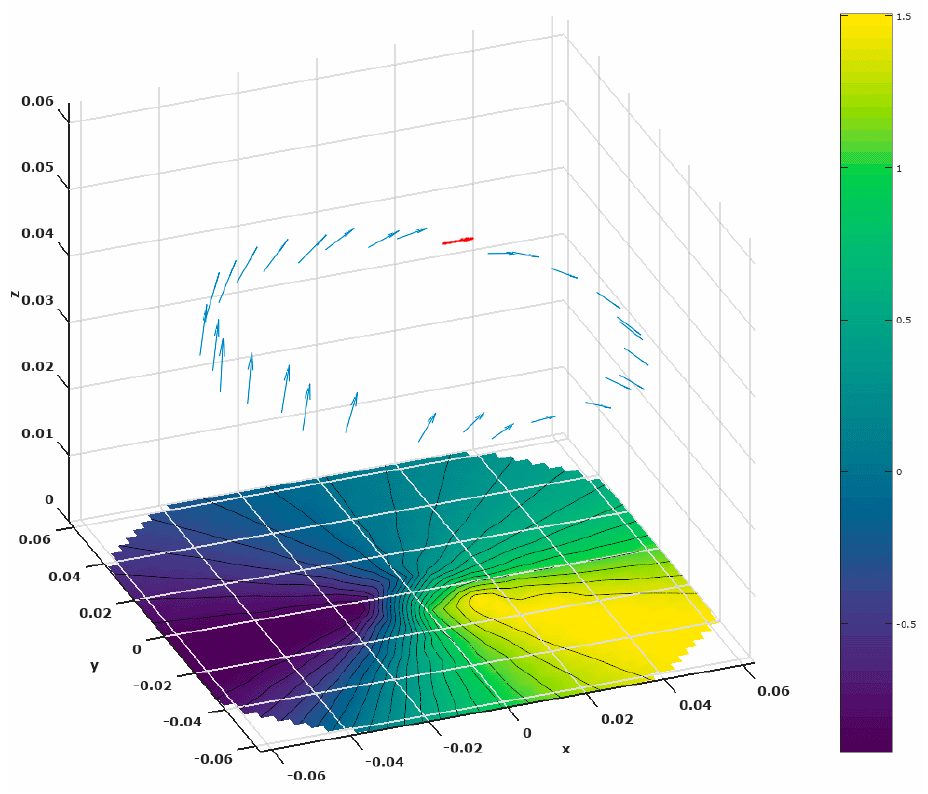
Figure 7. Dipolar sources that produce an Electroencephalogram (EEG) within 1% of the EEG produced by the true source (red). The surface EEG produced by the true source is plotted at the bottom of the figure.